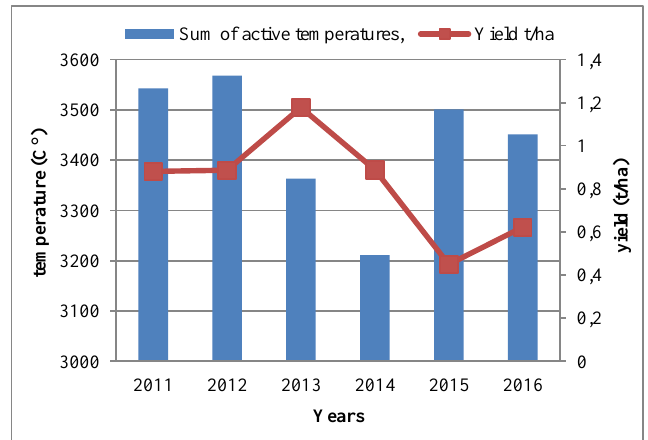
Figure 4. Dependence of the lovage seeds productivity on the sum of active temperatures during the vegetation periods of 2011-2016.